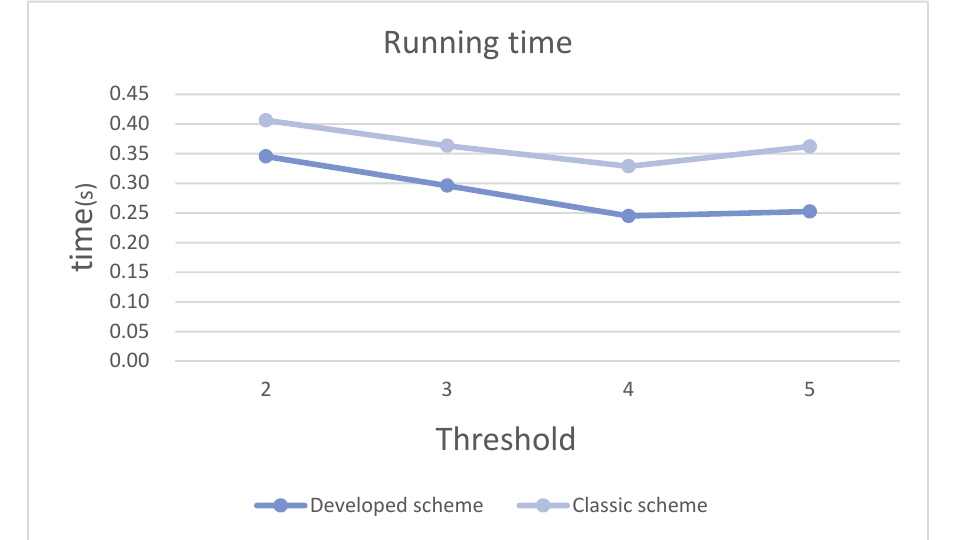
Figure 7. Running time comparison chart with different threshold in GF (251). Table 3. Running times with different sizes in GF (2 8 ).